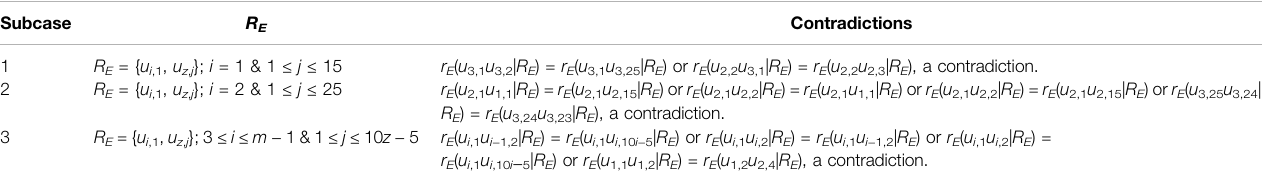
TABLE 2 | Case 2: When one vertex u l,1 lies on i th cycle and other u z,j lies on the z (cid:1) (i + 1) th cycle. Subcase R E